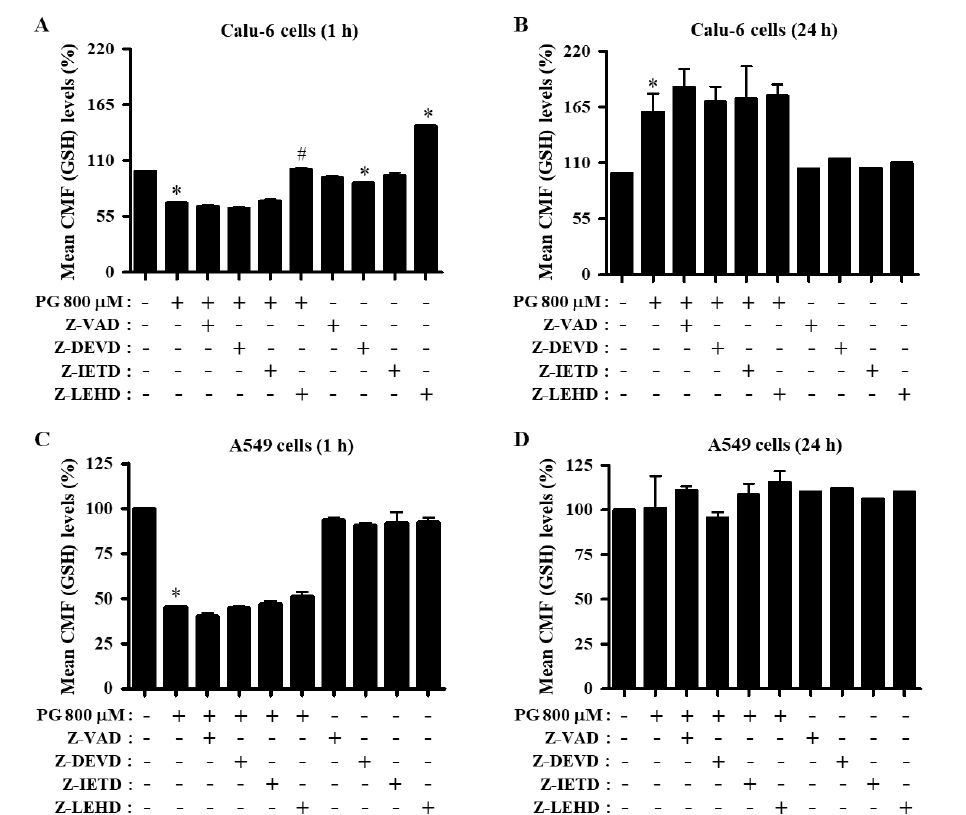
Figure 7. Effects of PG and caspase inhibitors on intracellular GSH levels in lung cancer cells. Exponentially growing cells were incubated with 800 µ M PG and/or each caspase inhibitor (15 µ M) for 1 or 24 h. Intracellular GSH levels in lung cancer cells were measured using a FACStar flow cytometer. ( A , B ) Graphs indicate mean CMF (GSH) levels (%) in Calu-6 cells at 1 h ( A ) or 24 h ( B ) compared with control cells. ( C , D ) Graphs indicate mean CMF (GSH) levels (%) in A549 cells at 1 h ( C ) or 24 h ( D ) compared with control cells. * p < 0.05 compared with the PG-untreated control group. # p < 0.05 compared with cells treated with PG only.